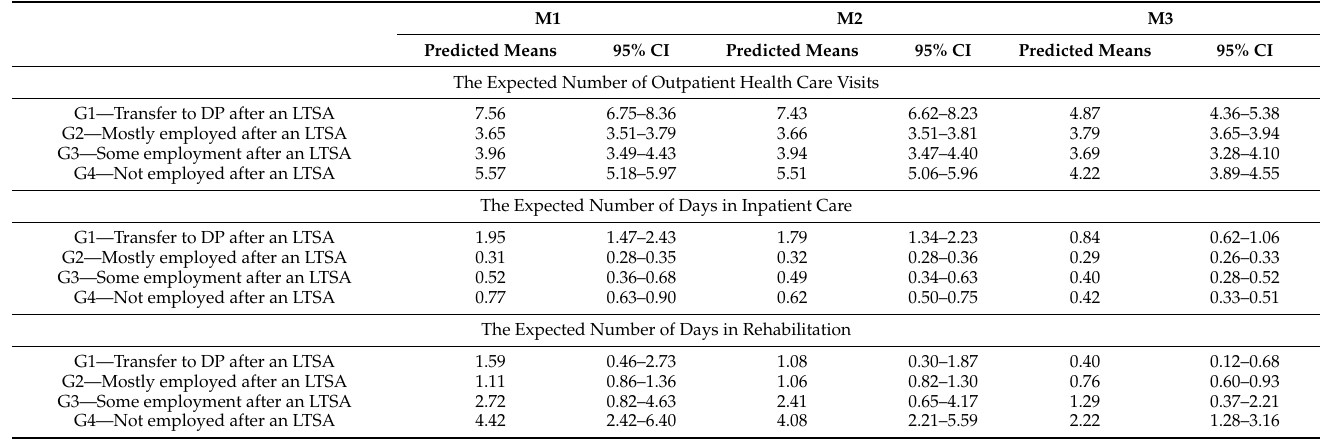
Table 2. Negative binomial regression analysis models. The LTSA groups’ expected number of outpatient health care visits, days in inpatient care and days in rehabilitation after the start of LTSA in (predicted means and 95% confidence intervals). M1 M2 M3 Predicted Means 95% CI Predicted Means 95% CI Predicted Means 95% CI The Expected Number of Outpatient Health Care